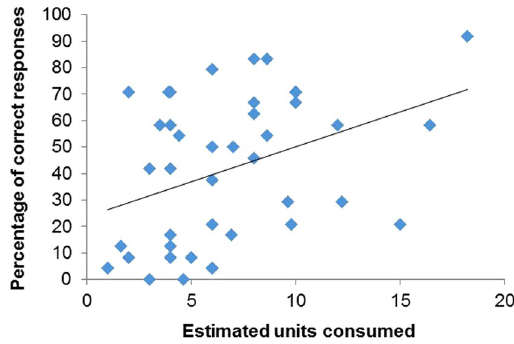
Figure 6. A significant positive correlation between the estimated units consumed in session one and proportion of correct responses during cued recall in session two within the alcohol condition only ( p = 0.015). The amount of alcohol consumed was positively related to scores on the retrograde memory test the following day, as individuals who consumed more shown enhanced